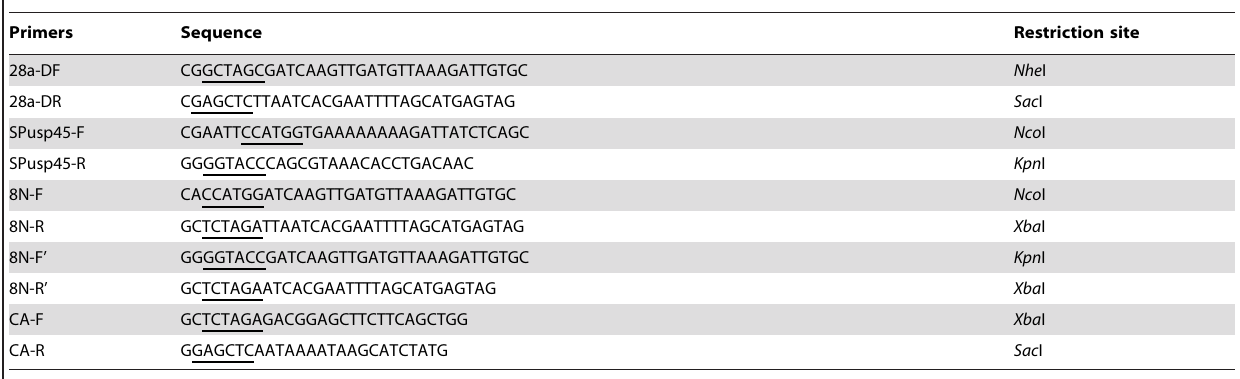
Table 2. Primers used in this